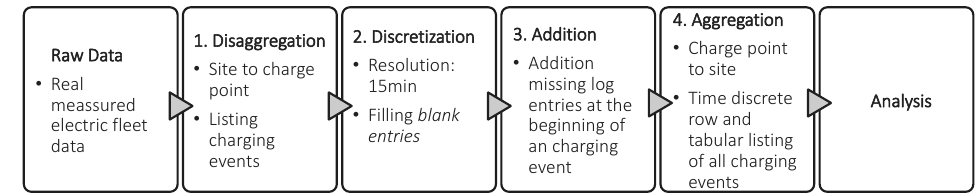
Figure 1. Toolchain: from raw data to flexibility